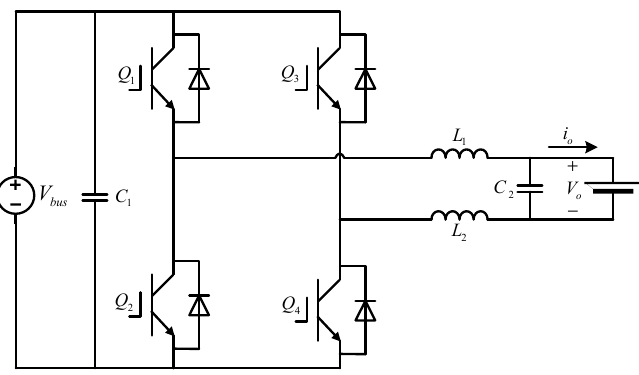
Figure 2. Main circuit of bidirectional DC-DC converter.